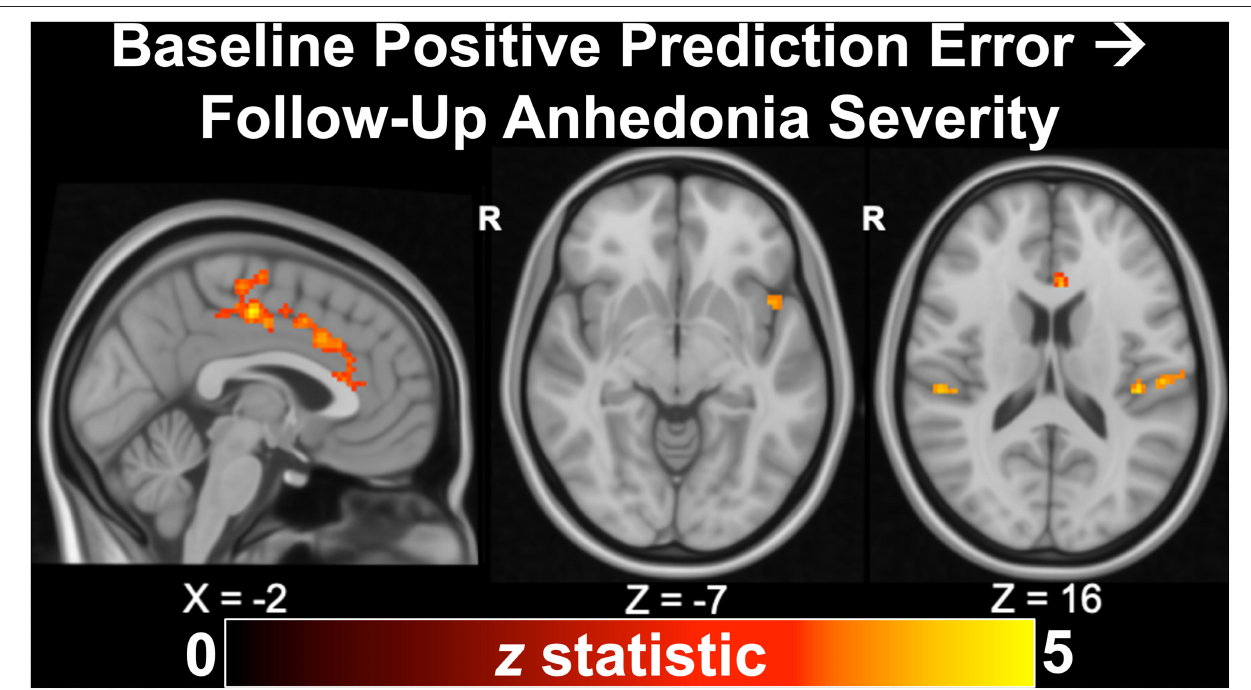
FIGURE 5 | Activation to positive prediction errors in the Reward Flanker Task predicted clinical outcomes at ∼ 24 months follow-up, including anhedonia severity ( p TFCE − FWE < 0.05), in a longitudinal study of 32 adolescents (22 with mood/anxiety symptoms, 10 healthy controls). Excerpted from